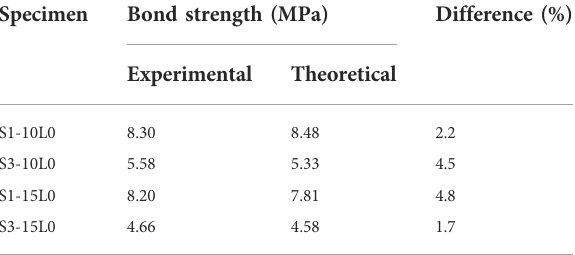
TABLE 5 Theoretical and experimental bond strengths between NSM and intact concrete. Specimen